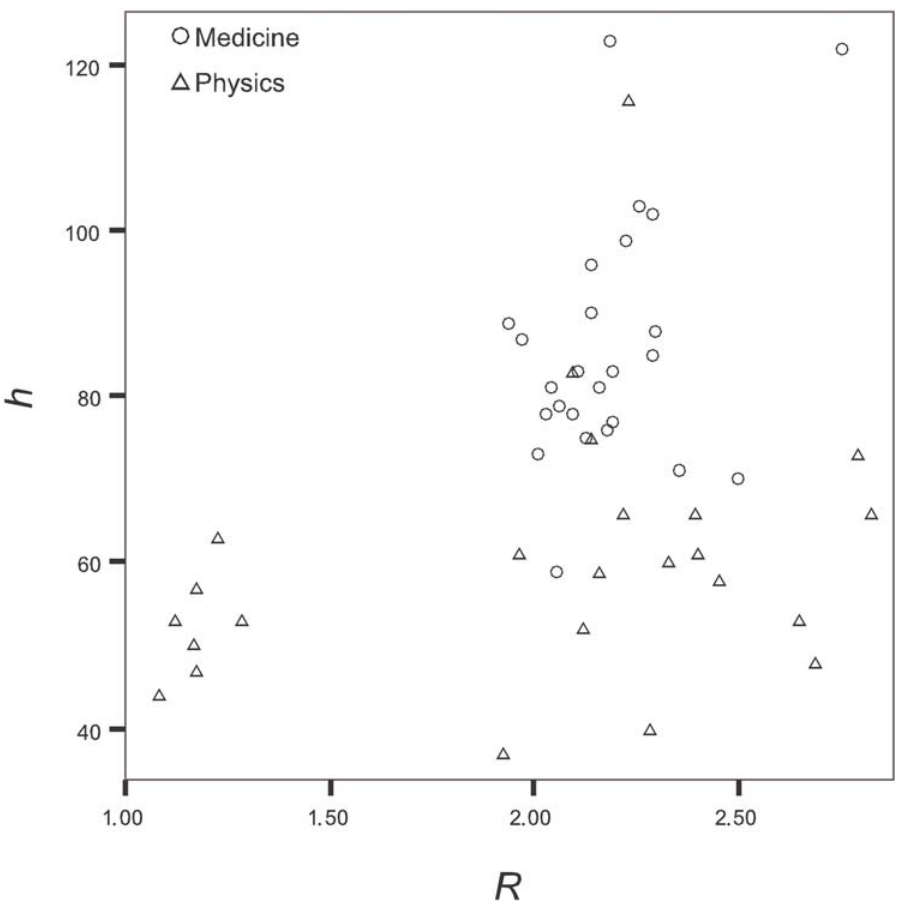
Figure 2. Citation h index as a function of R for the scientists of Figure 1.